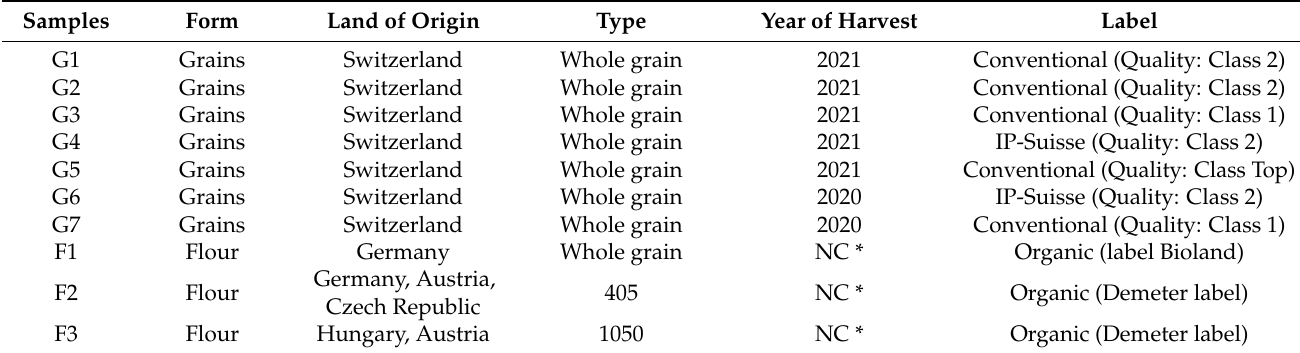
Table 1. List of samples analyzed during the